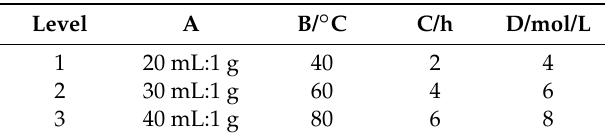
Table 3. Acid leaching factors.